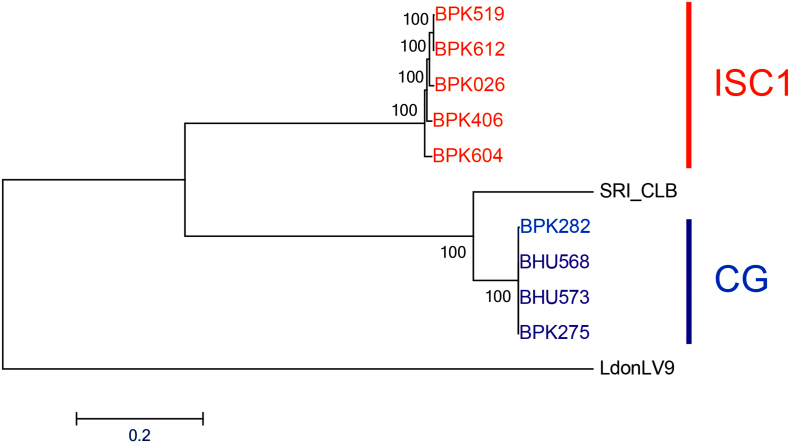
Neighbour joining tree based on whole genome SNP loci. Bootstrap support was calculated on 1000 bootstrap replicates. LdonLV9 = East African L. donovani LV9, SRI_CLB = Sri Lankan L. donovani SRI_CLB.